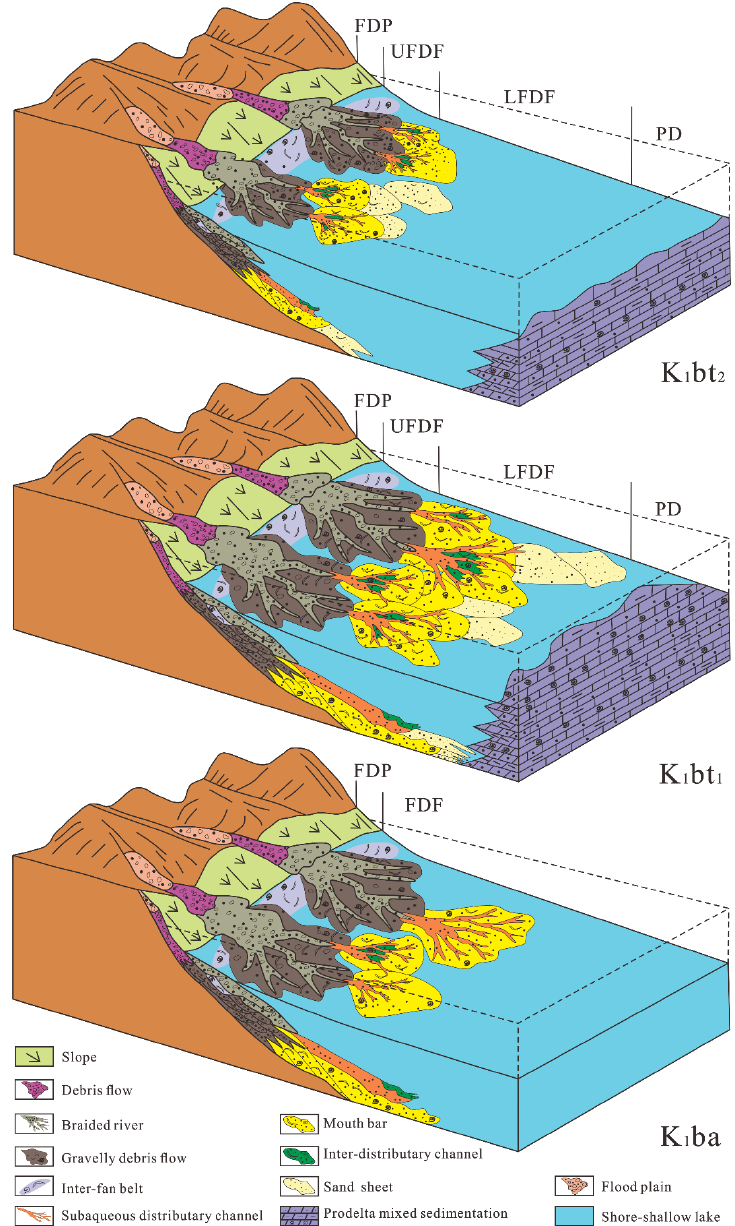
Figure 14. Sedimentary facies types and models of fan delta in Saidong sub-sag, not to scale. Abbre- viations: FDP, fan delta plain; UFDF, upper fan delta front; LFDF, lower fan delta front; PD, prodelta.